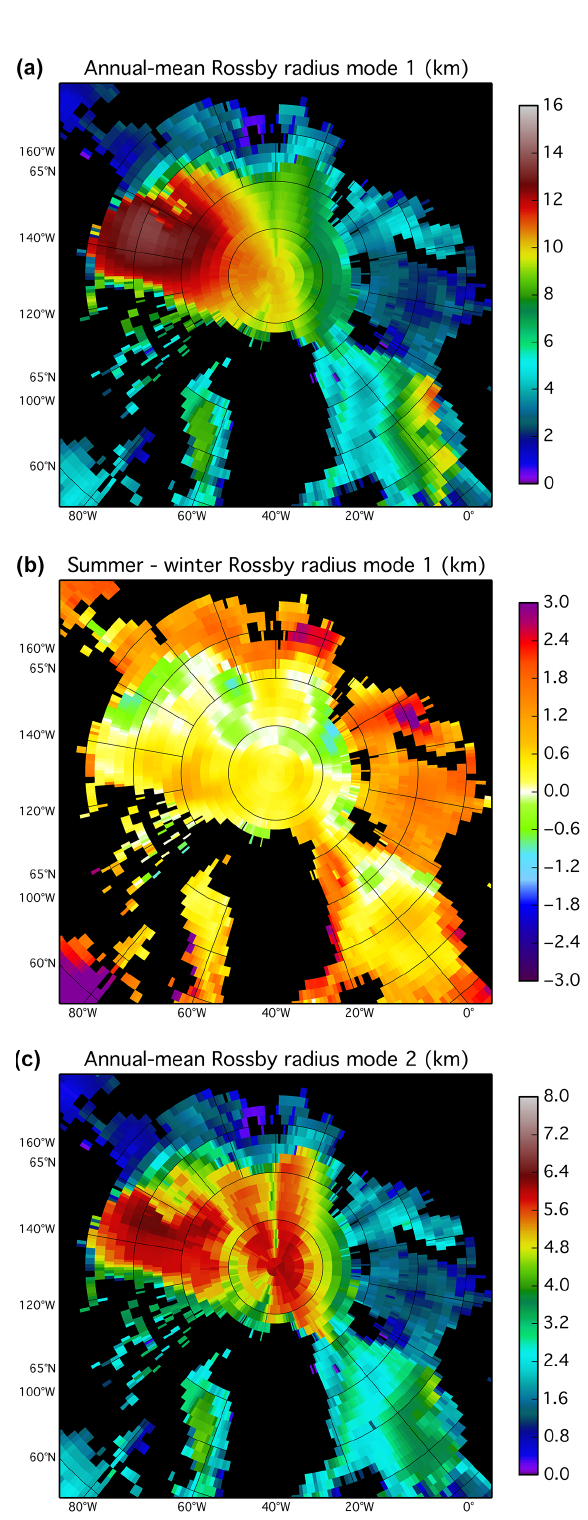
Figure 2. (a) PHC annual mean Rossby radius (km), mode 1. (b) PHC Rossby radius (km), mode 1, seasonal difference (summer minus winter). (c) PHC annual mean Rossby radius (km), mode